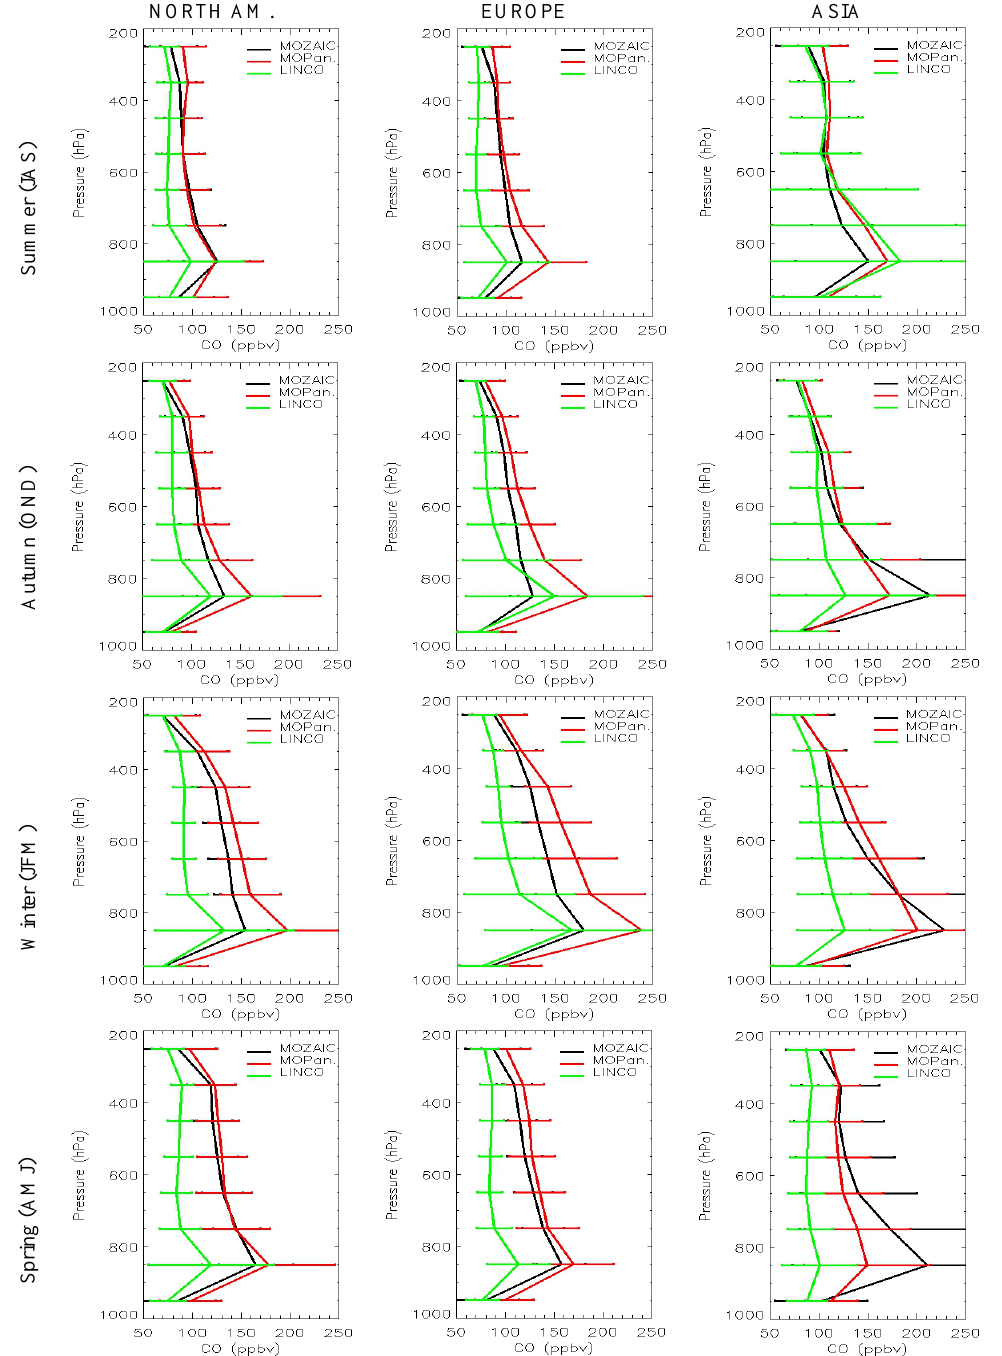
Fig. 10. Mean profiles of CO in parts per billion by volume (ppbv) from LINCO (green lines), MOZAIC (black lines) and MOPITT CO assimilated fields (red lines) in 2004–2005 NH summer July-August-September (JAS) autumn October-November-December (OND) winter January-February-March (JFM) and spring April-May-June (AMJ) over North America (right), Europe (center) and Asia (right).